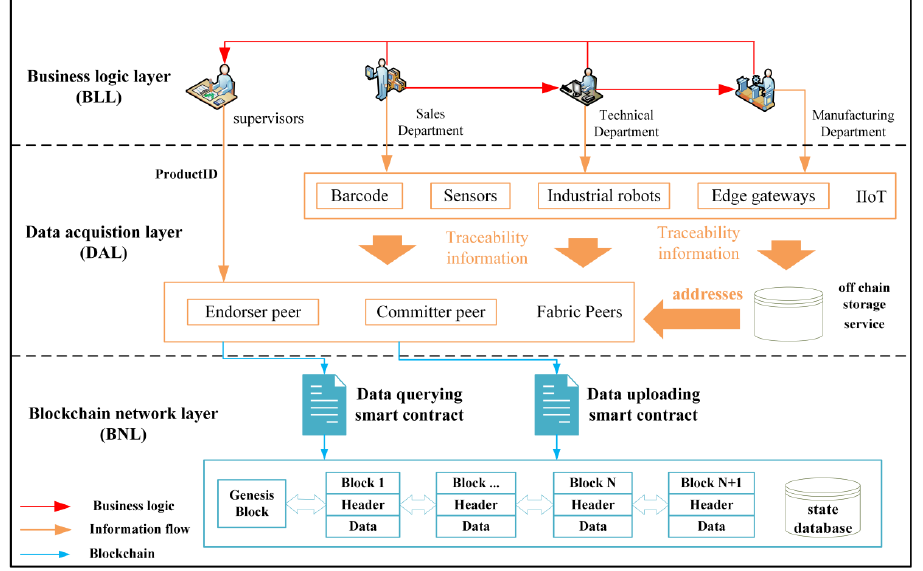
Figure 2. The architecture of BPDMS.